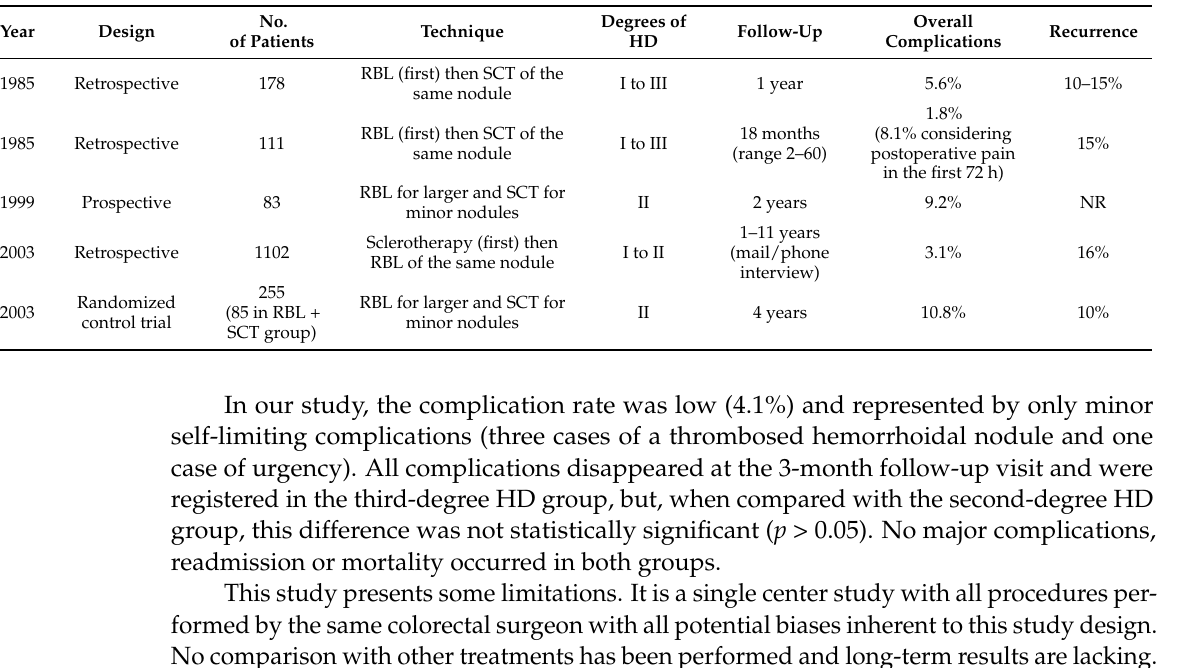
Table 3. Published studies reporting concomitant use of sclerotherapy and rubber band ligation to treat hemorrhoidal disease